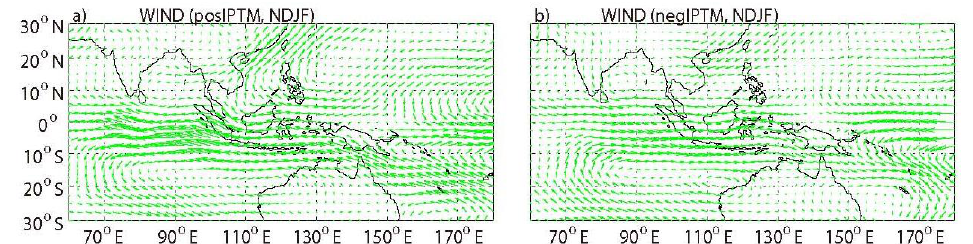
Figure 12. Composite horizontal wind field at 850 hPa (m·s −1 ) in winter (November to February in the following year) during ( a ) positive and ( b ) negative phases of PIOAM.